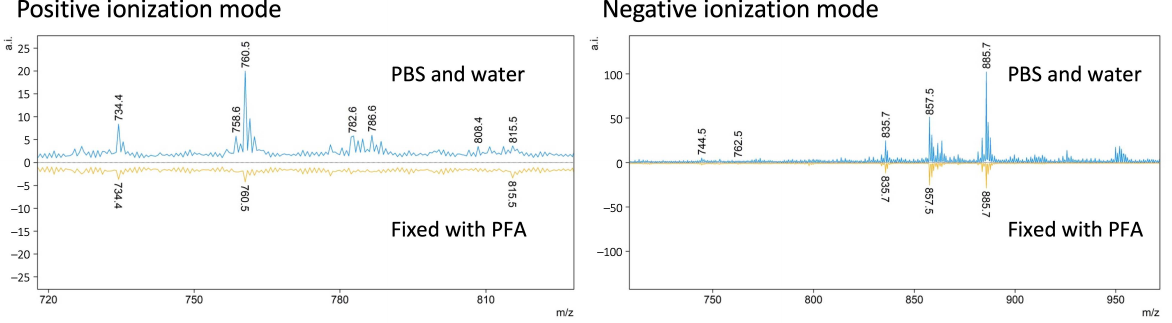
Figure 15. The comparison of the spectra of the oocytes washed with PBS and washed in PBA and fixed with PFA in the positive and negative ionization